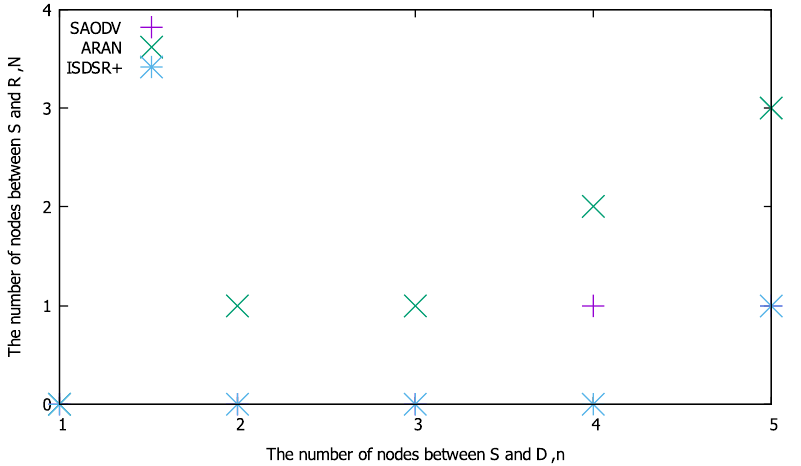
Figure 6. Threshold of N for n at which the proposed method is superior to the compared methods in terms of calculation